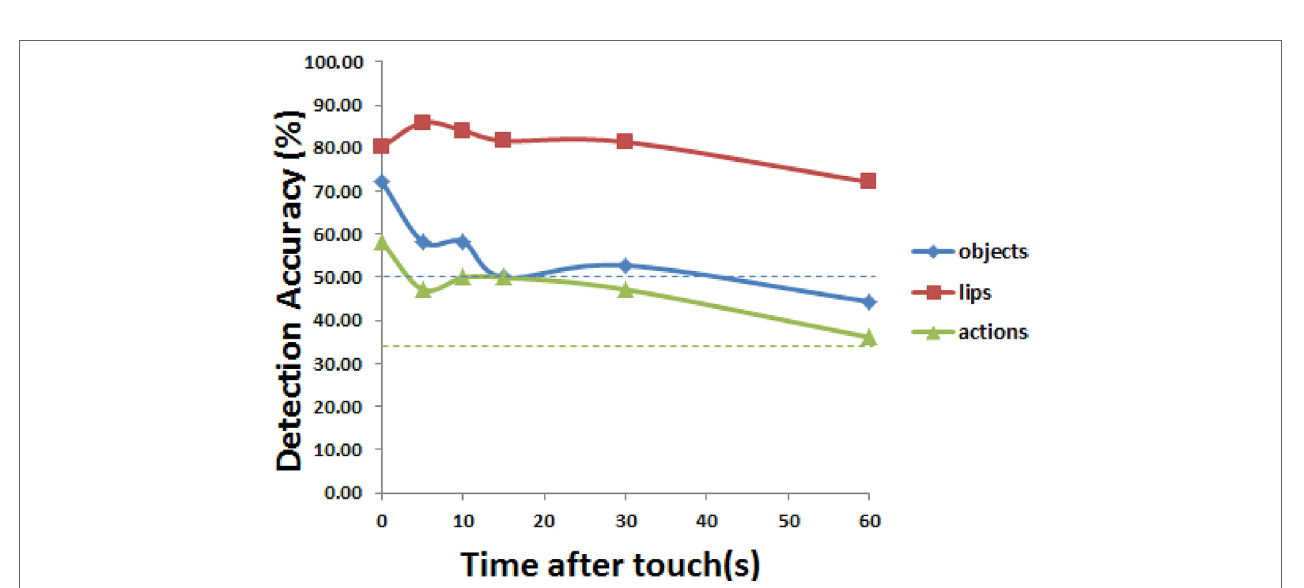
FigUre 16 | Accuracies for touch detection on objects and lips, as well as action inference, over